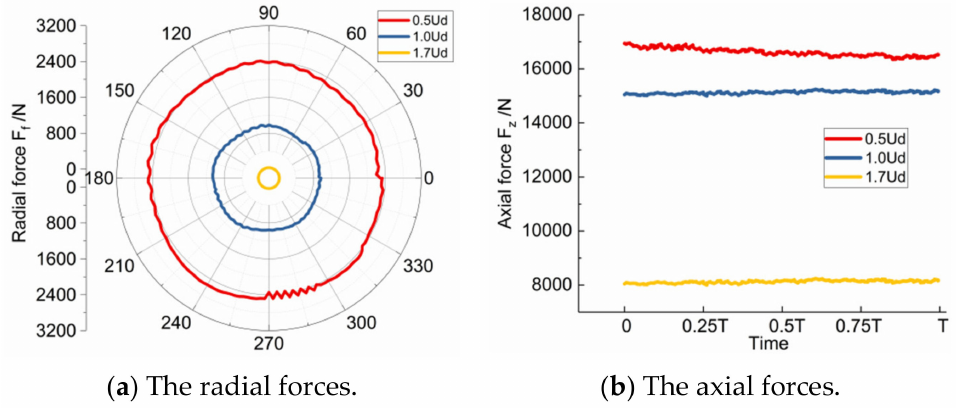
Figure 22. The calculated forces under different cruising speeds.